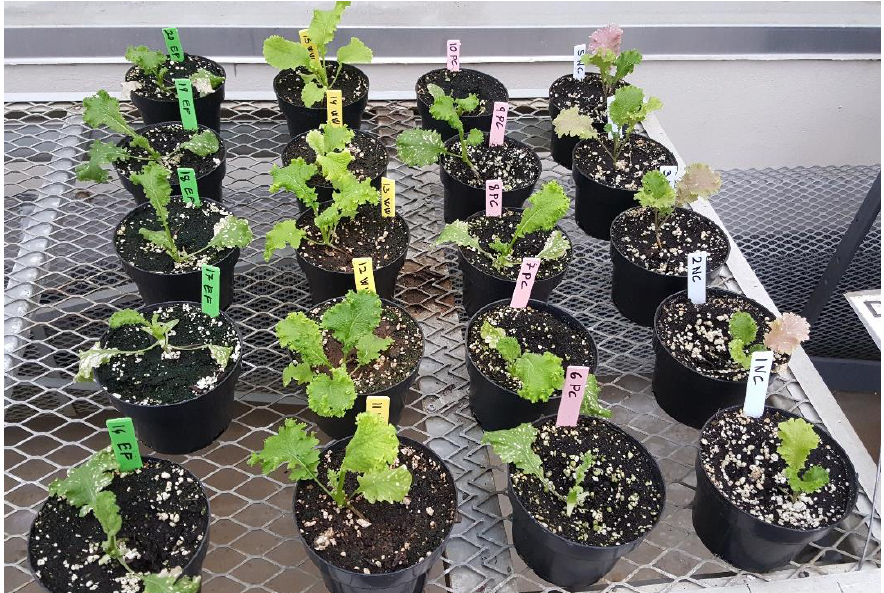
Figure 1. Image of ‘Green Wave’ mustard green plants (day 42) grown in University of Minnesota’s Plant Growth Facilities greenhouse (St. Paul, MN). Plants were grouped by fertility treatment in rows; from left to right: digested wastewater, raw wastewater, inorganic fertilizer, and no fertilizer.